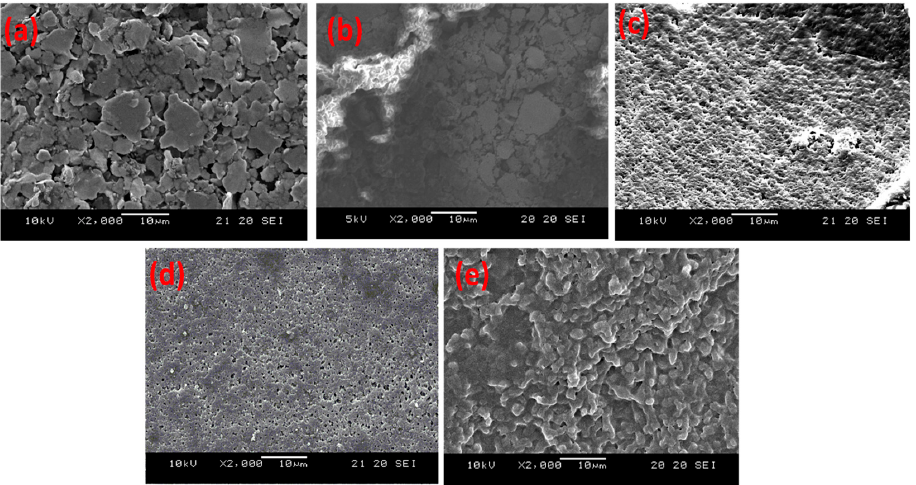
Figure 6. SEM morphologies of ( a ) untreated sample, and composite gels containing ( b ) 0 mL; ( c ) 1.5 mL; ( d ) 3.0 mL; and ( e ) 4.5 mL AuNPs (2000×)